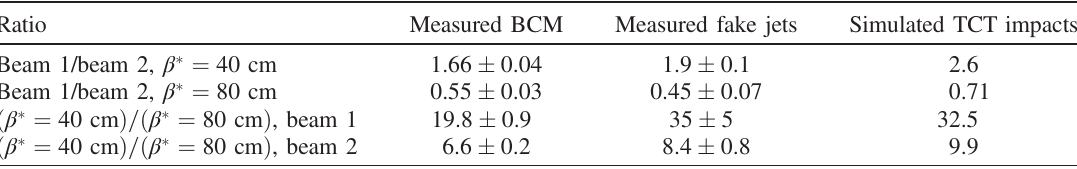
TABLE VI. Ratios of measured background counts per TCP hit between various configurations, calculated from Table II, shown together with the corresponding ratios of simulated hits on the TCTs, taken from Table V. The average background over horizontal and vertical losses is considered. For the simulations, the sum of hits on the horizontal and vertical TCTs is used. For β (cid:1) ¼ 40 cm the TCT setting of 8 . 8 σ is considered, which is closest to the 2016 operational